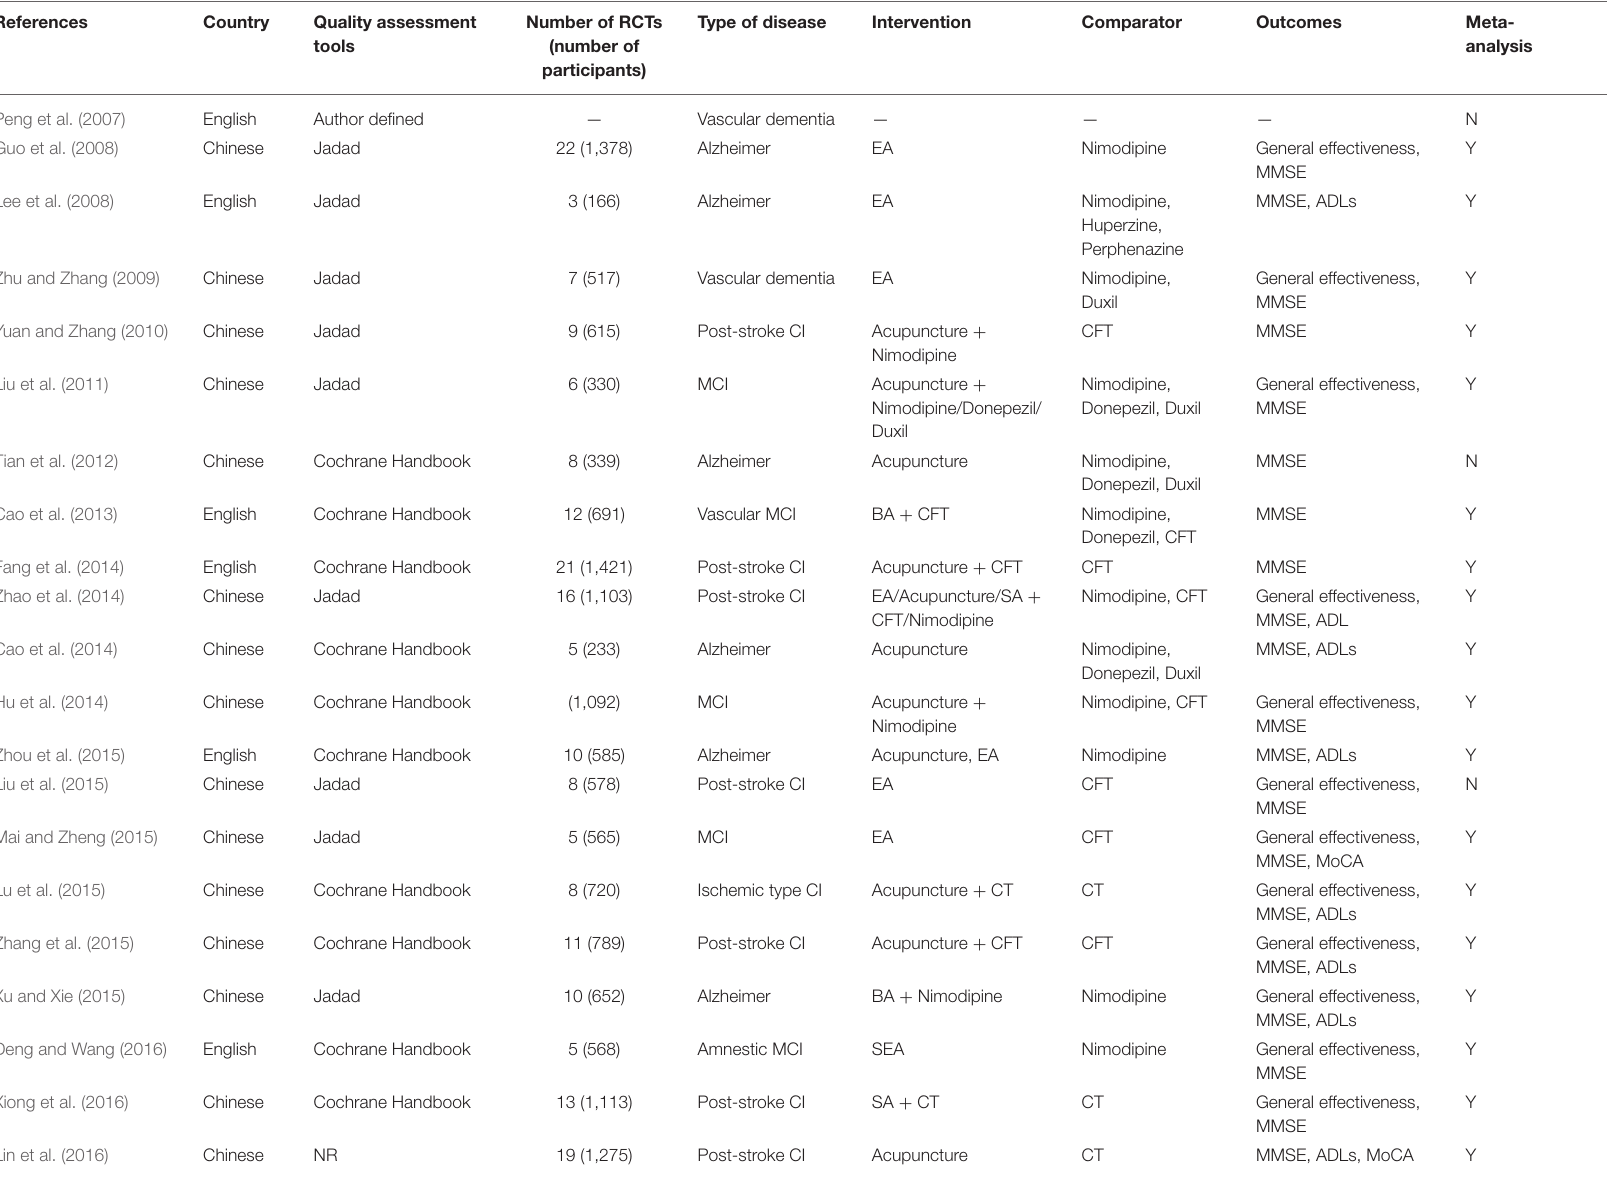
TABLE 1 | Characteristics of included systematic reviews and meta-analyses of randomized controlled